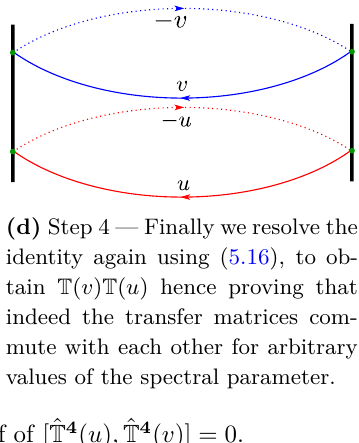
Figure 9. Diagrammatic proof of